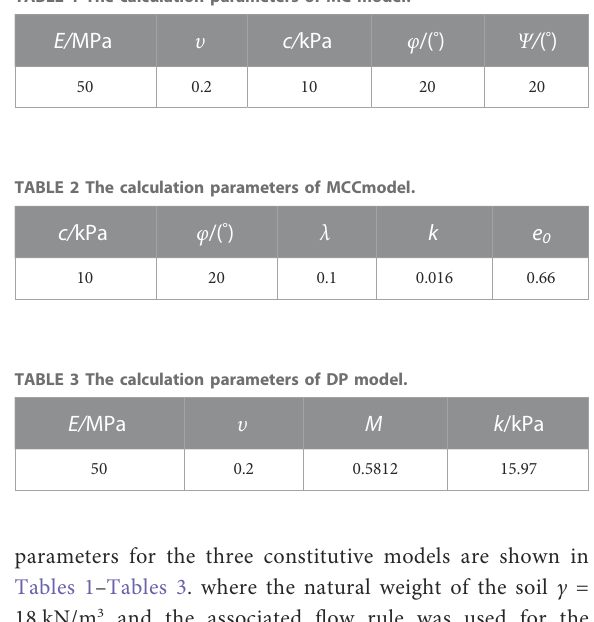
TABLE 1 The calculation parameters of MC model.